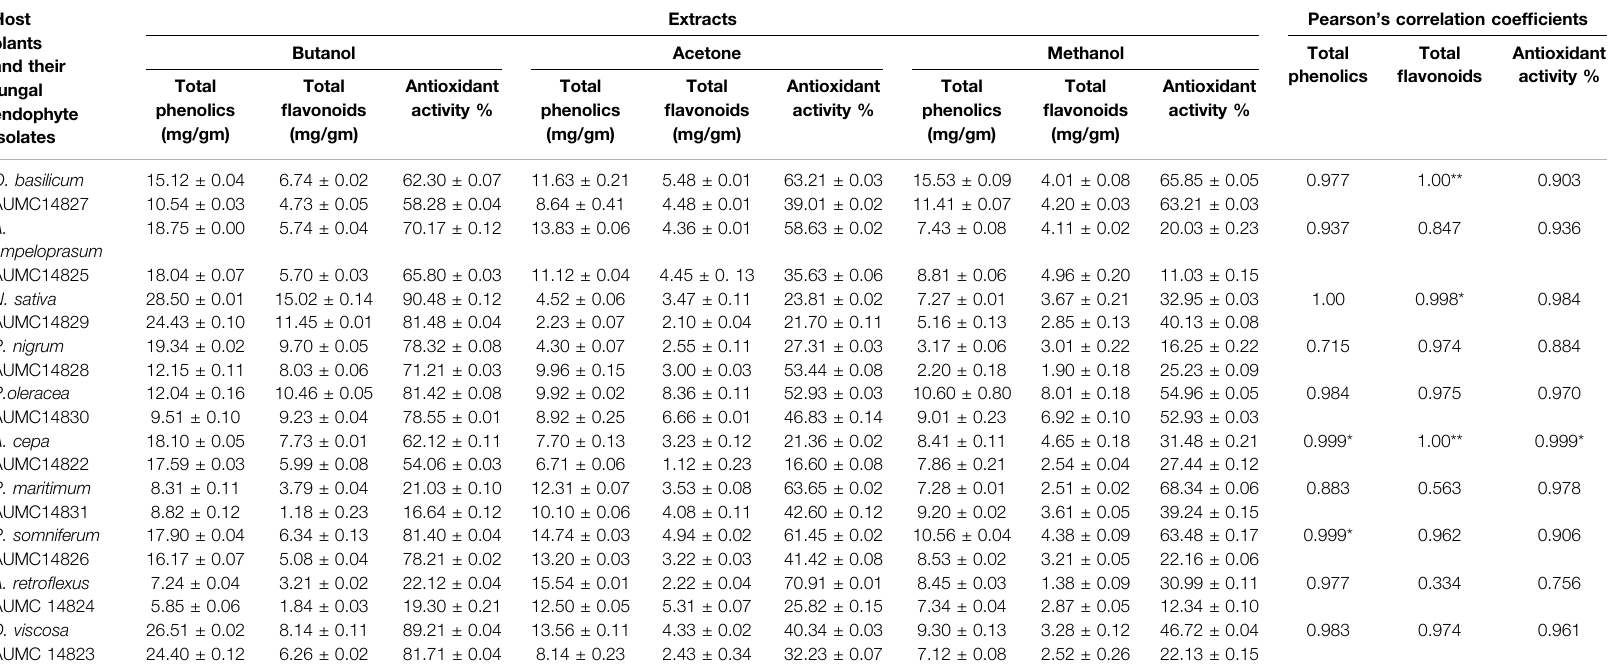
The data were given as averages of three replicates (Mean ± SE). *Correlation is signi fi cant at the 0.05 level (2-tailed). **Correlation is signi fi cant at the 0.01 level